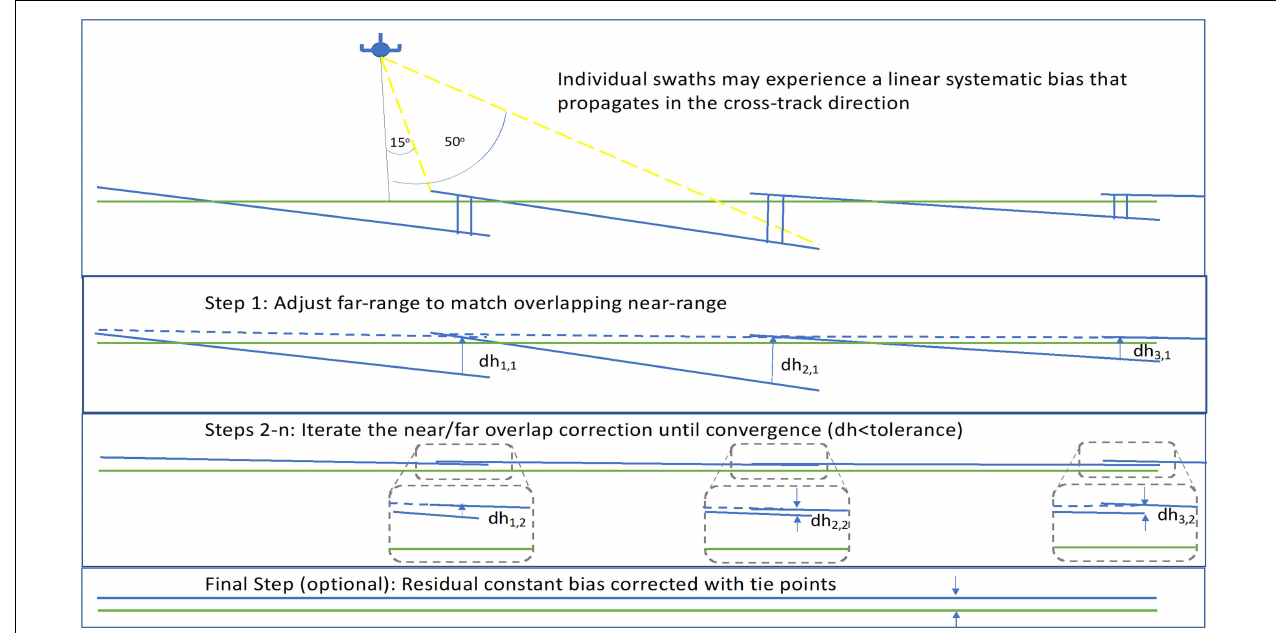
FIGURE 3 | Schematic of InSAR data calibration and de-trending